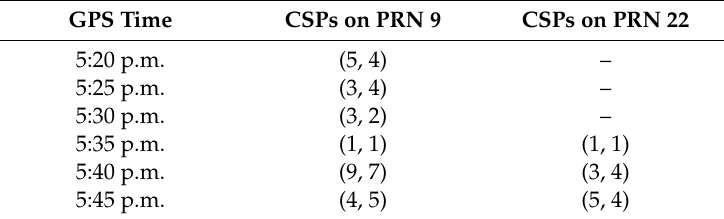
Figure 6. GOCE satellite latitude, elevation, and second-order time-difference PIR (STPIR) (1 s) for GPS PRN 9 and PRN 22 on 21 November 2009. Table 4. Simulated special CSPs at GOCE satellite GPS observations.